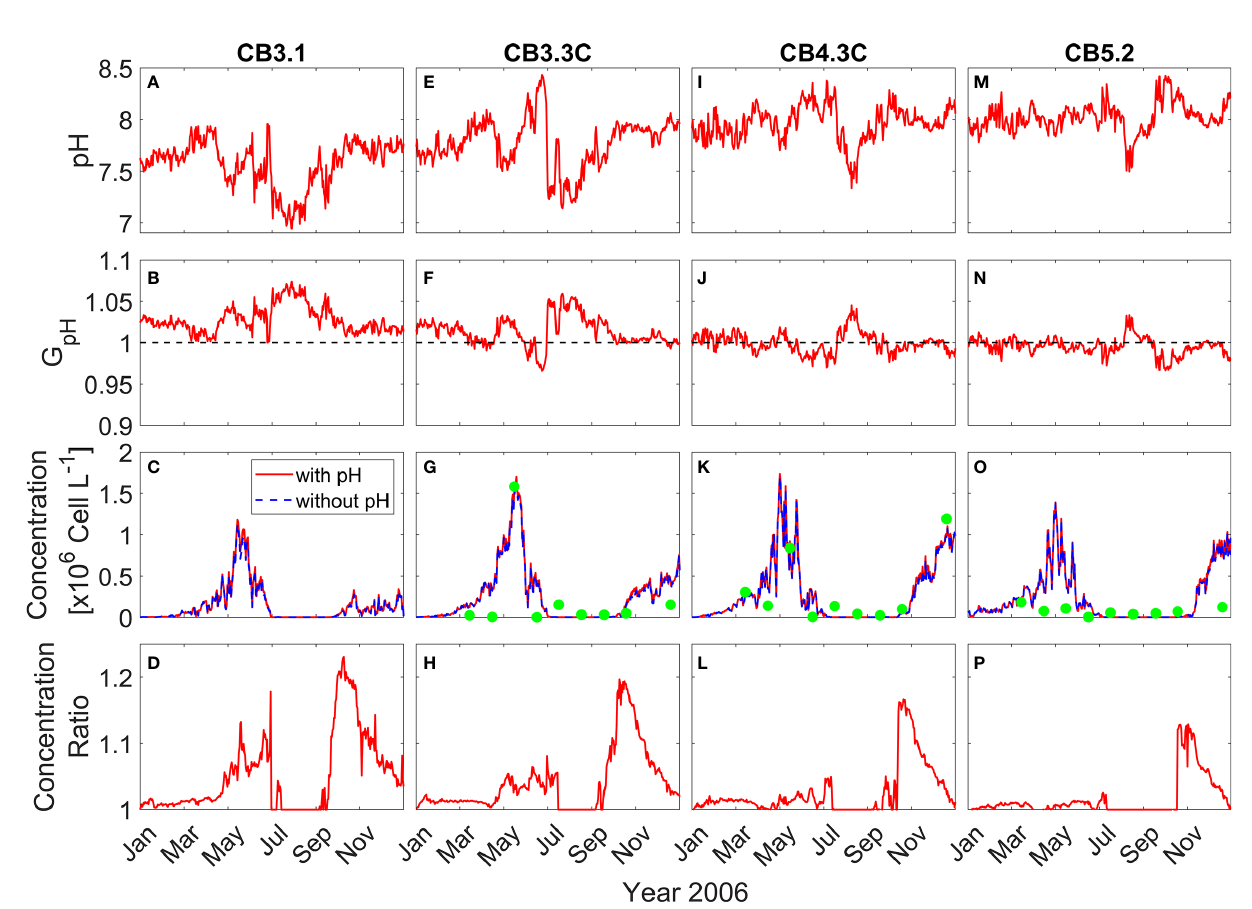
FIGURE 4 | Time series of daily surface pH (A, E, I, M) , G pH (B, F, J, N) , P. minimum cell concentration (C, G, K, O) , and ratio of P. minimum concentration under pH effects to that without pH effects (D, H, L, P) in year 2006 at 4 mainstem stations marked in Figure 2A . Red solid lines represent the model results considering pH effects and blue dashed lines represent the model results without pH effects. Green dots represent the observed monthly mean P. minimum